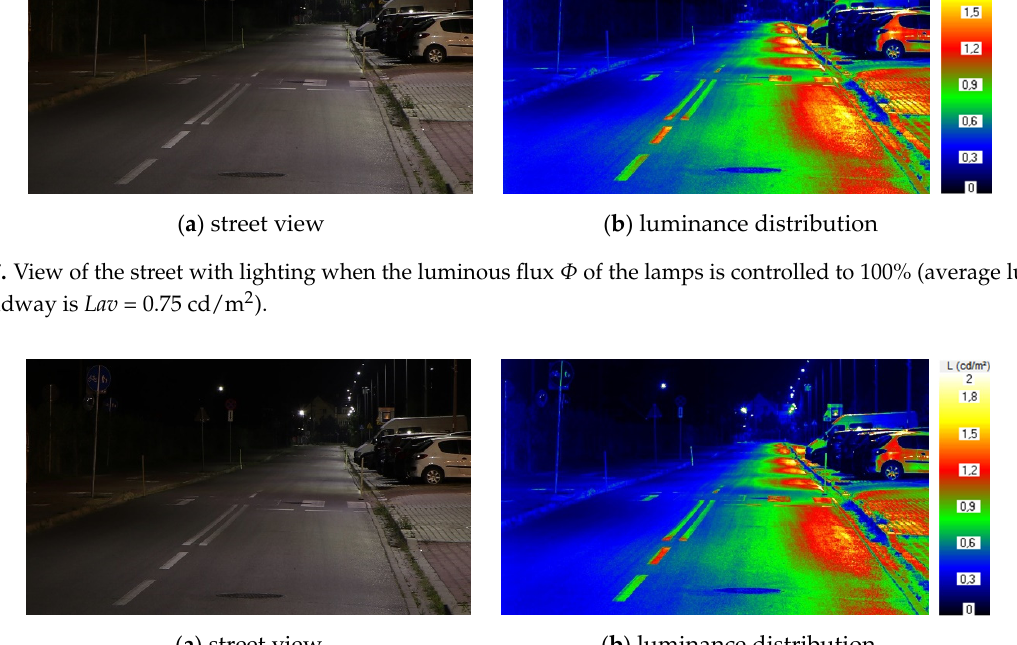
( b ) luminance distribution Figure 19. View of the street with lighting when the luminous flux Φ of the lamps is controlled to 67% (average luminance of the roadway is Lav = 0.50 cd/m 2 ). ( a ) street view ( b ) luminance distribution Figure 20. View of the street with lighting when the luminous flux Φ of the lamps is controlled to 57% (average luminance of the roadway is Lav = 0.43 cd/m 2 ). ( a ) street view ( b ) luminance distribution Figure 21. View of the street with lighting when the luminous flux Φ of the lamps is controlled to 40% (average luminance of the roadway is Lav = 0.30 cd/m 2 ).